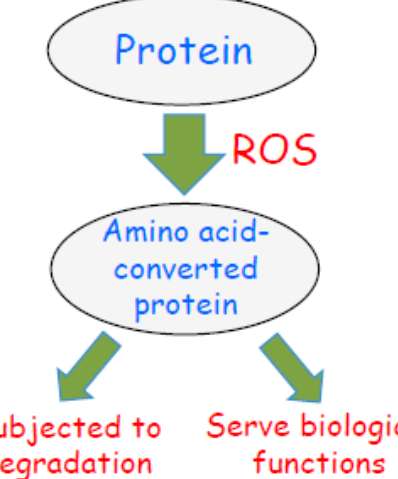
Figure 5. Scheme depicting the fate of amino acid-converted proteins in response to biological oxidation. Reactive oxygen species (ROS) are produced during oxidative stress or oxidant signaling. ROS promote amino acid conversions as described in this article. Some of these amino acid-converted proteins are subjected to protein degradation as a mechanism of oxidative stress. I propose that amino acid-converted proteins also possess biologic functions as nature